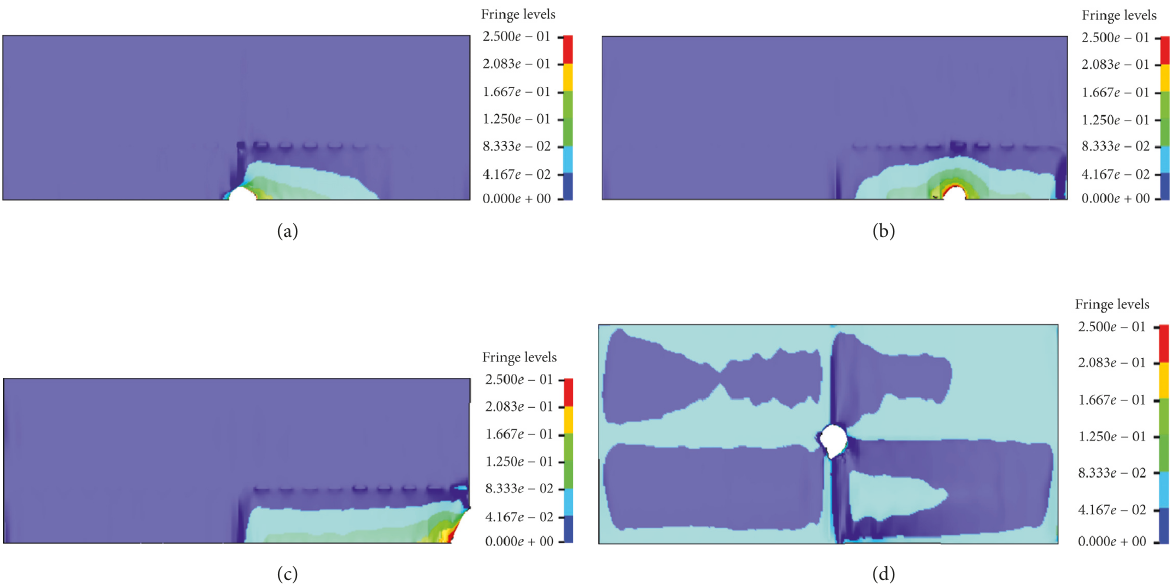
Figure 13: Fringe plot of the final displacement of the bottom plate (top view, unit: m). (a) Position 1. (b) Position 2. (c) Position 3. (d) Position 4.